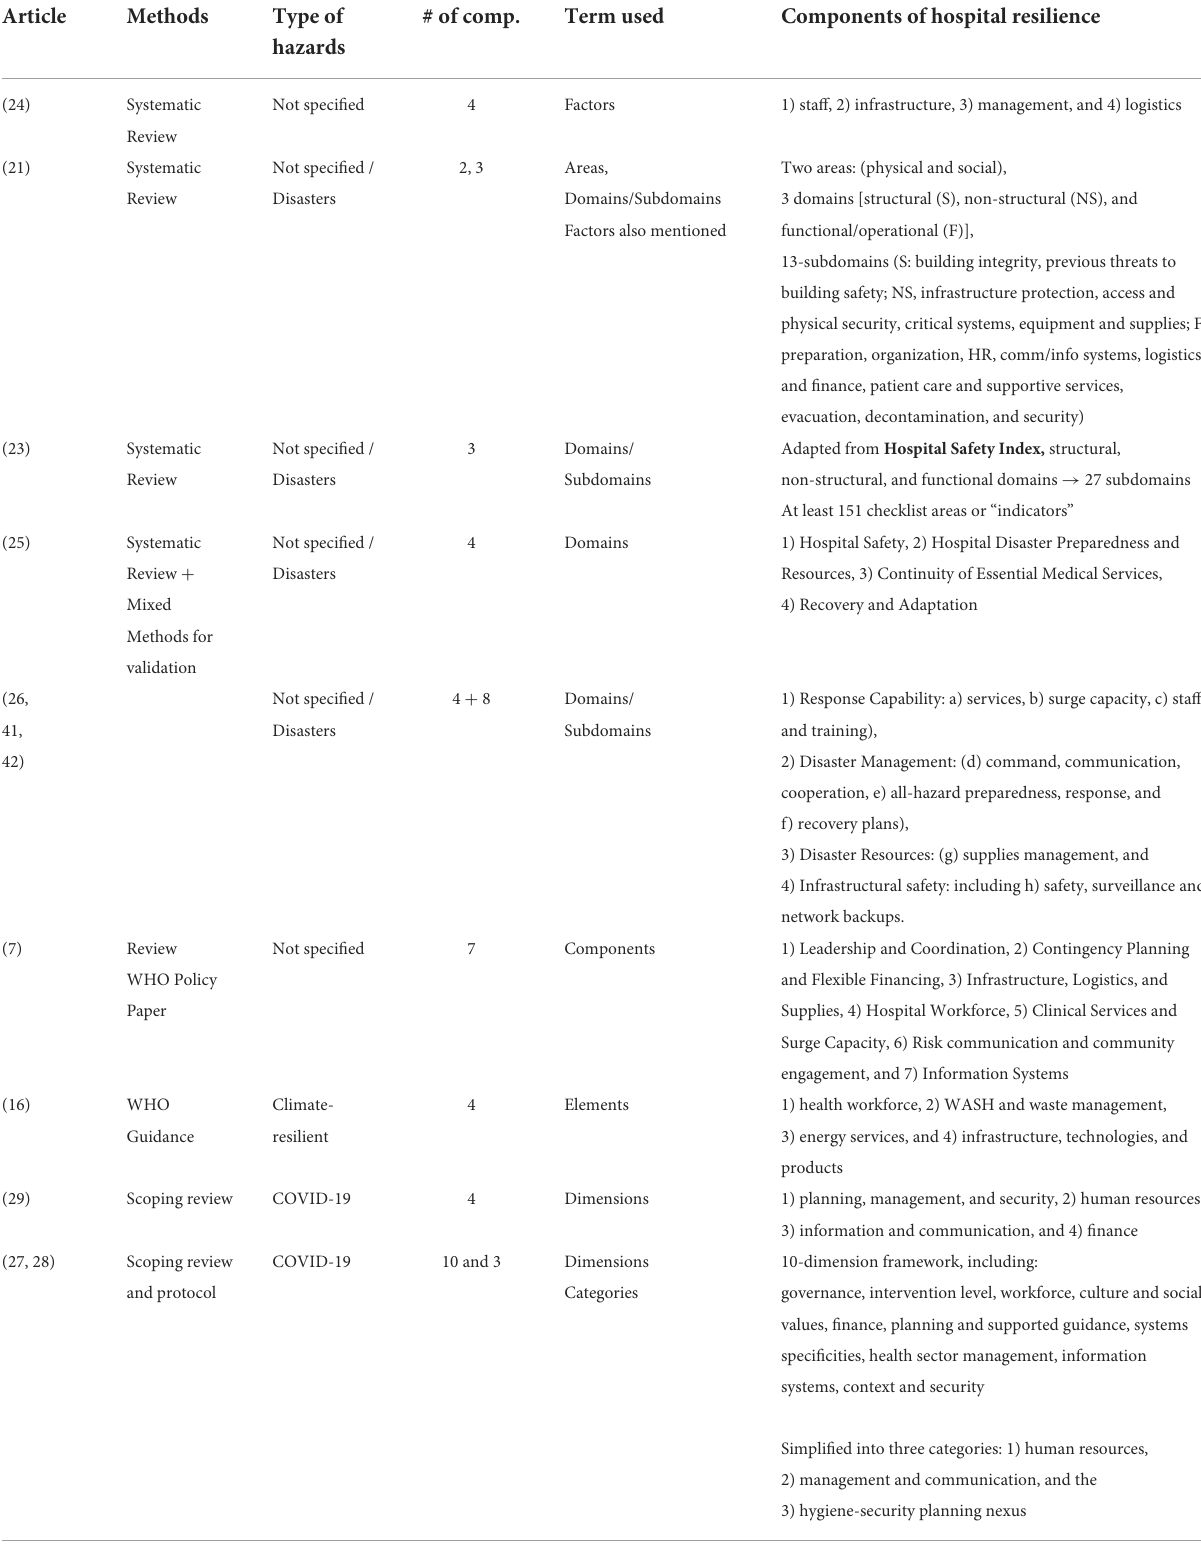
TABLE 3 Components across global guidelines, systematic and scoping reviews on hospital